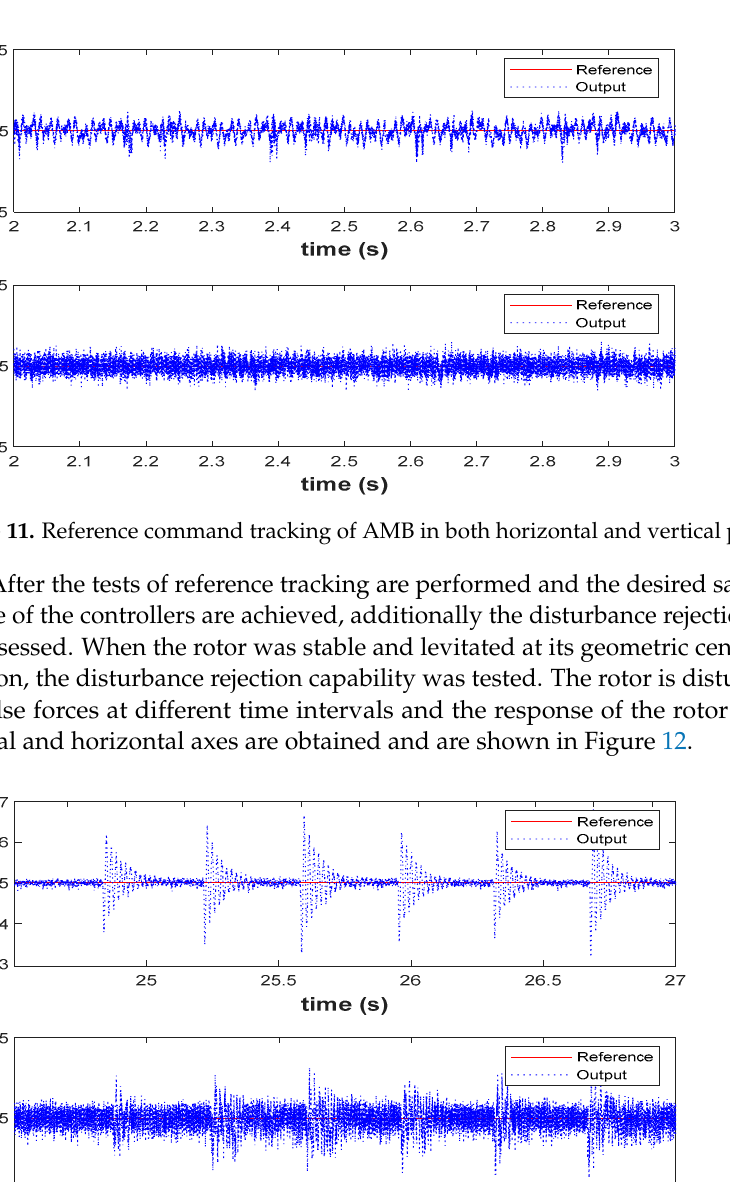
Figure 12. Disturbance rejection capability of 2-DOF AMB, when external disturbances are ap- plied.